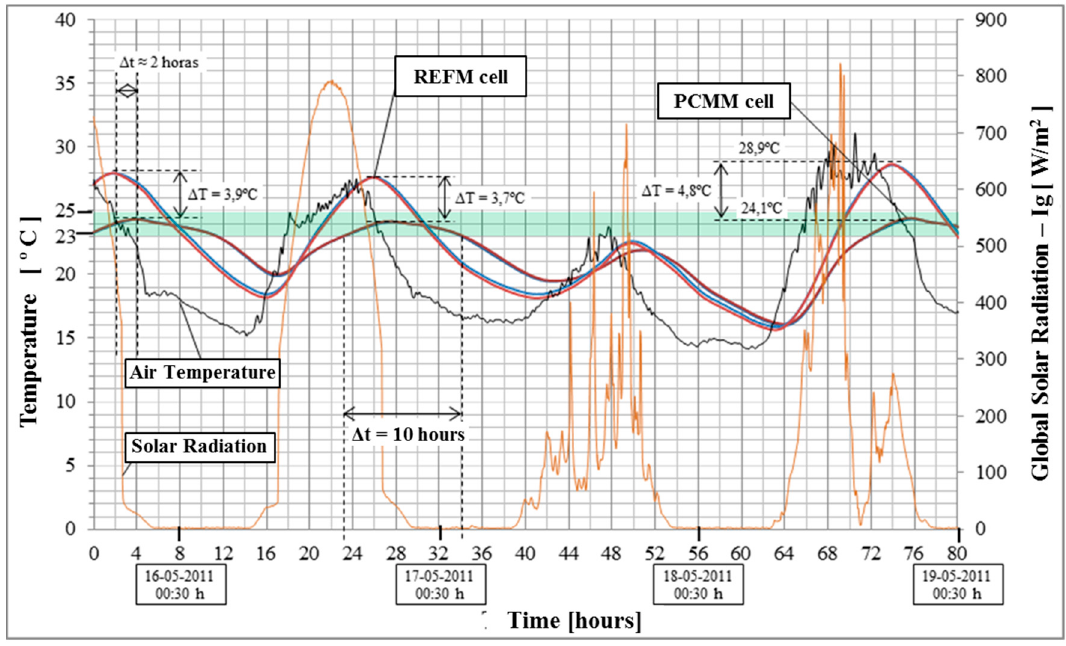
Figure 9. Experimental results of exterior temperature, global solar radiation and internal temperature of the cells (base and geometric center).